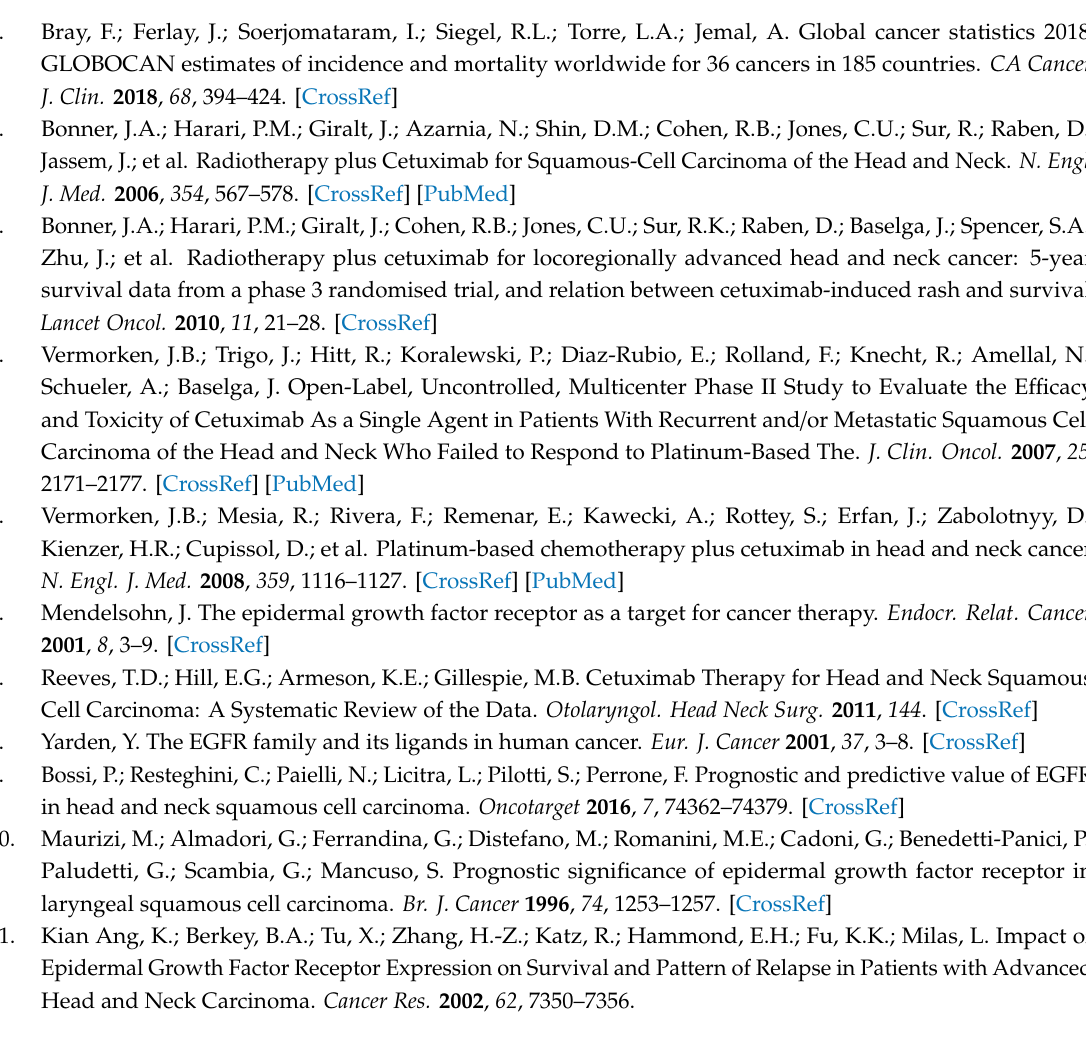
the study. Table S2: Di ff erential expression analysis. Table S3: Complete KEGG